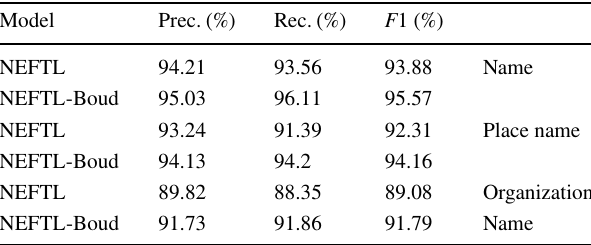
Table 2 Experimental results of solid boundary detection method